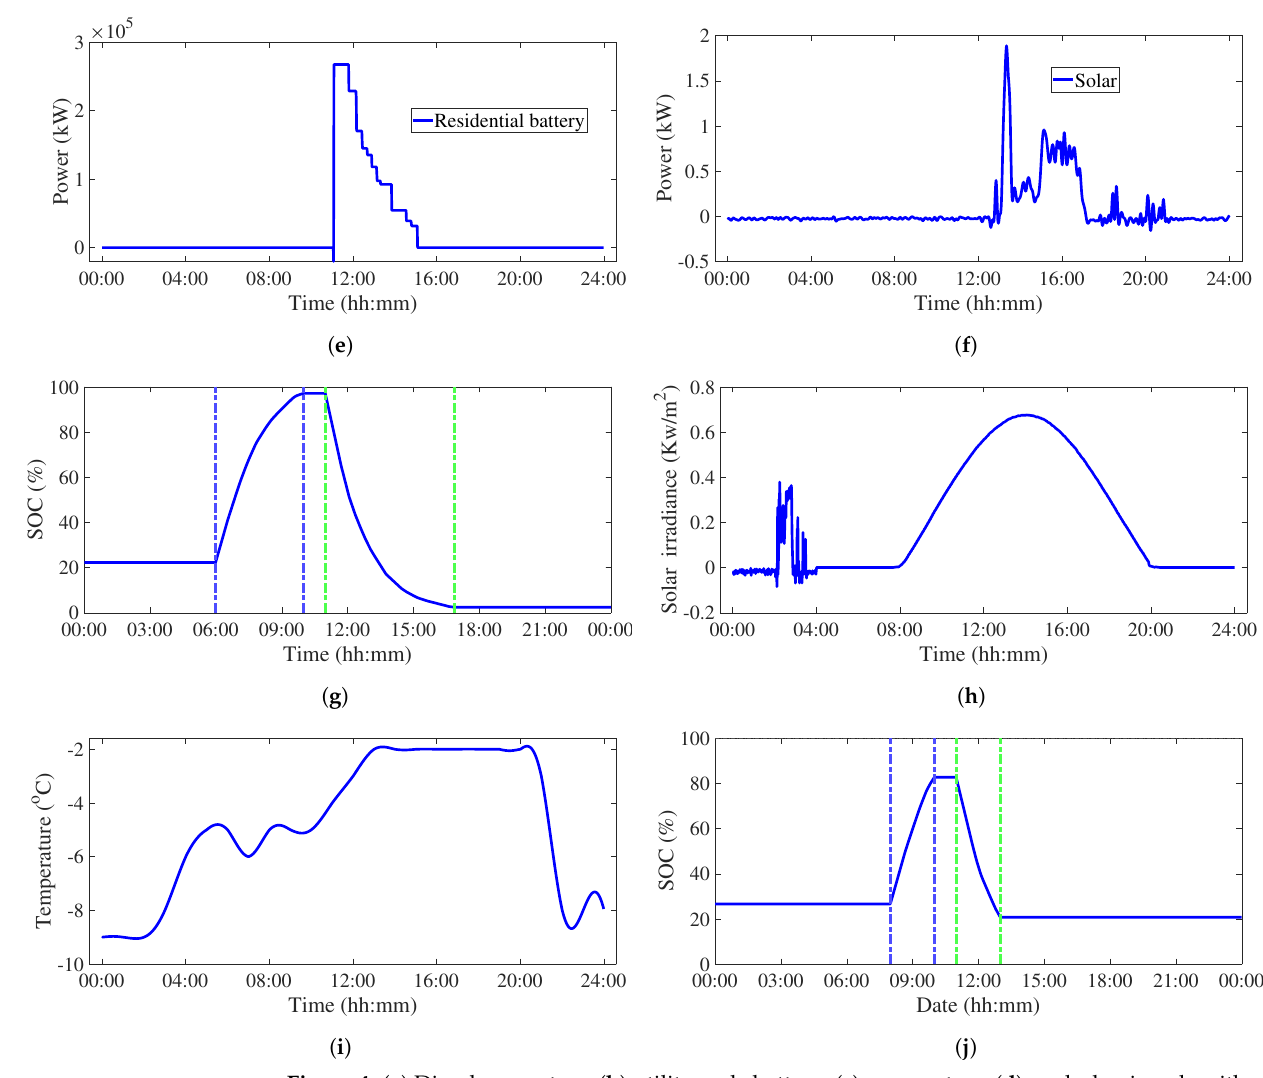
Figure 4. ( a ) Diesel generators; ( b ) utility scale battery; ( c ) aggregators; ( d ) peak shaving algorithm; ( e ) residential battery; ( f ) solar power; ( g ) RB state of charge; ( h ) solar irradiance; ( i ) area temperature on 1 February 2021; ( j ) UB state of charge. Table 3. Contributions of EERs for Monthly Peak Load